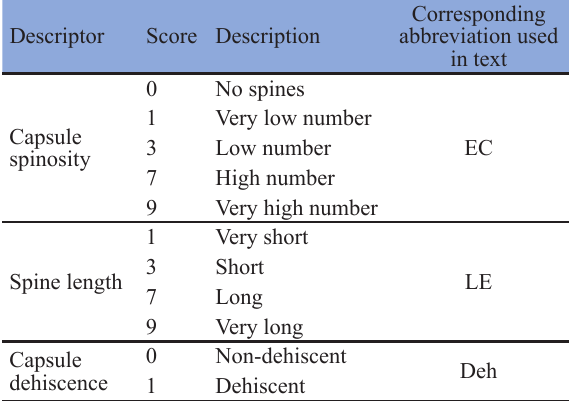
Table 3 . Qualitative descriptors used to characterize achiote ( Bixa orellana L.)